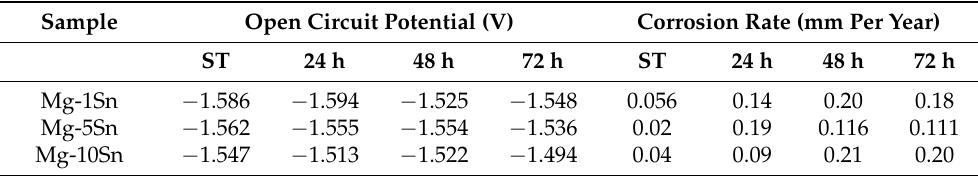
Table 3. Corrosion rate measurement of Mg-Sn alloys from immersion